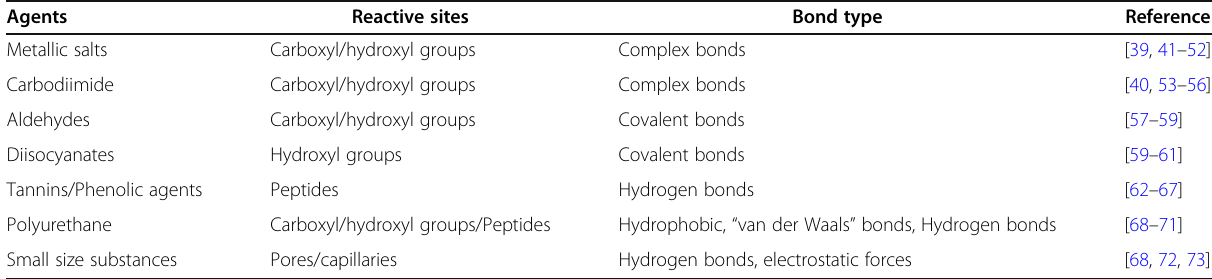
Table 1 Modification agents for